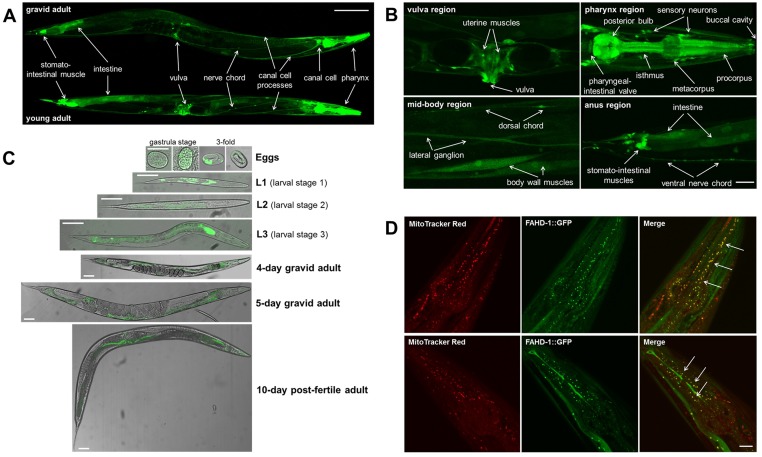
Expression and subcellular localization of FAHD-1 in nematodes.(A) Young adult and gravid adult hermaphrodites of the transcriptional reporter N2;Ex[pfahd-1GFP, pRF4] were monitored by confocal microscopy. fahd-1 seems to be expressed in most tissues, including pharynx, canal cell, neurons, vulva, intestine, and stomato-intestinal muscle. Representative pictures are shown. Size bar = 100 μm. (B) Confocal images of young adult C. elegans of the transcriptional reporter N2;Ex[pfahd-1GFP, pRF4]. Representative images are shown. Size bar = 10 μm. Upper left panel: Detailed picture of fahd-1 expression in the peri-vulvar region; vulva and uterine muscles are stained positive. Upper right panel: Detailed picture of fahd-1 expression in the pharyngeal region; buccal cavity, procorpus, metacorpus, isthmus, posterior bulb, and pharyngeal-intestinal valve, as well as sensory neurons in the head were stained positive. Lower left panel: Detailed picture of fahd-1 expression in the mid-body region; body wall muscles, lateral ganglion, dorsal chord (DC), and ventral nerve chord (VNC) were stained positive. Lower right panel: Detailed picture of fahd-1 expression in the anus region; the stomato-intestinal muscles, the anus and the intestine were stained positive. (C) Temporal expression pattern of fahd-1. The translational reporter N2;Ex[pfahd-1FAHD-1::GFP, pRF4] was examined (and pictured) by confocal fluorescence microscopy from the time point the eggs were laid at gastrula stage to 10-day old post fertile adults. GFP fluorescence was overlaid with phase-contrast microscopy. The FAHD1-1::GFP fusion protein is present in all stages from gastrulation to old worms. Representative images are shown. Size bar = 50 μm. (D) Young adult hermaphrodites of the translational reporter N2;Ex[pfahd-1FAHD-1::GFP, pRF4] expressing the FAHD-1::GFP fusion protein (shown in green) were stained with 100 nM MitoTracker Red (shown in red) overnight. Shown here are confocal pictures of the pharynx region of the worm recorded in the green and red channel, as well as the merged pictures. Regions of overlapping staining (shown in yellow) are indicated by arrows. Representative pictures are shown. Size bar = 10 μm.